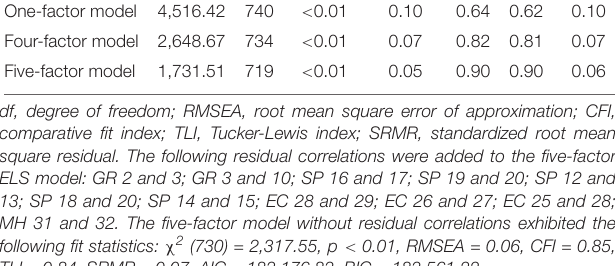
TABLE 2 | Model fit statistics for the 40-item Enriched Life Scale (ELS) ( n = 529).